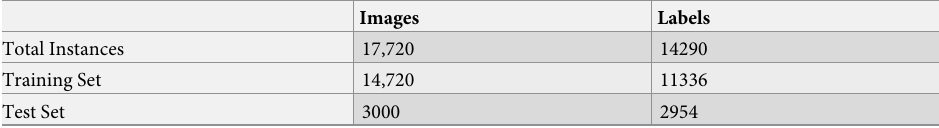
Table 2. Training and testing set for E-Commerce product images